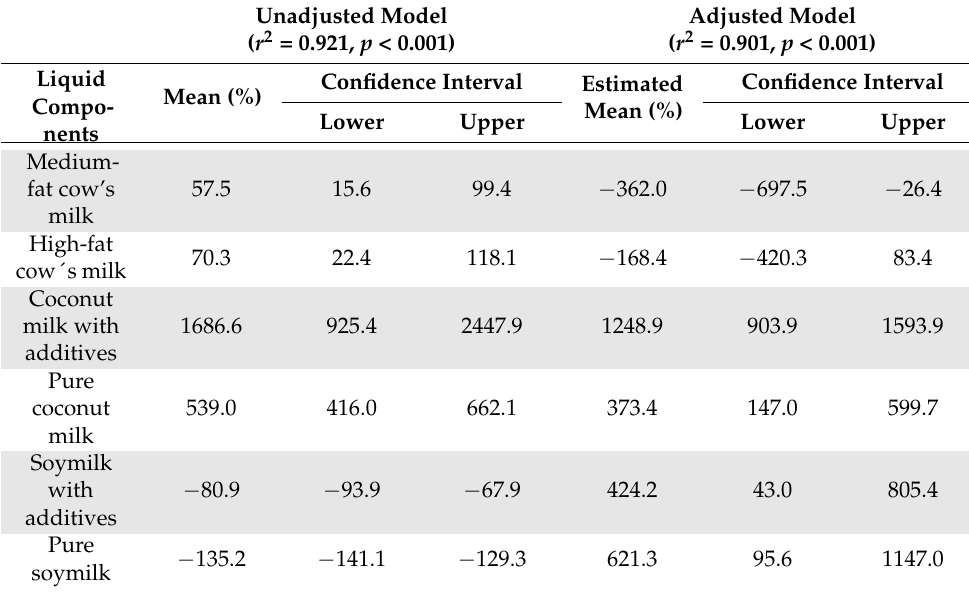
Table 4. Improvement in lutein liberation per gram of protein before and after adjustment for fat. Unadjusted